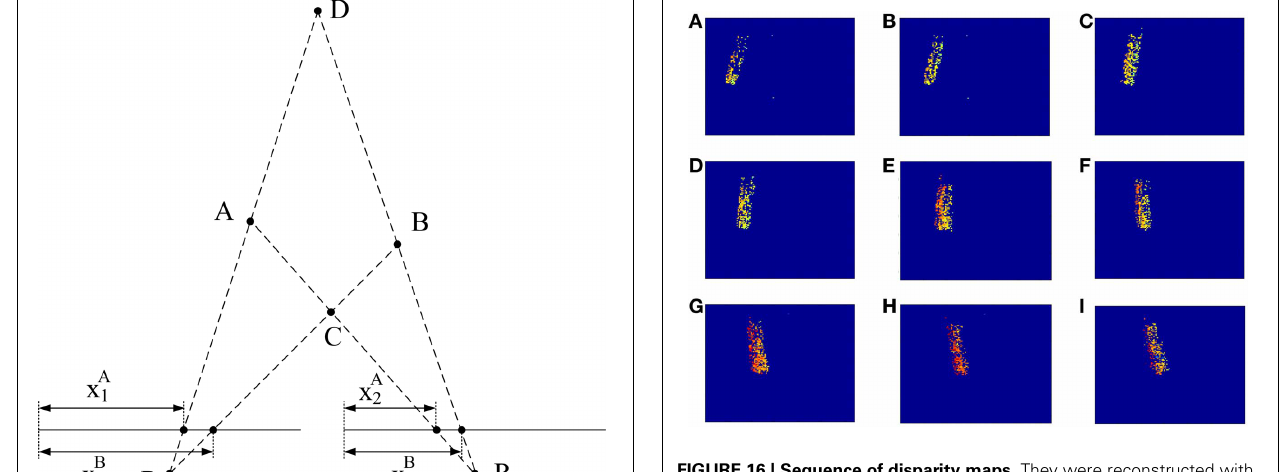
FIGURE 16 | Sequence of disparity maps. They were reconstructed with T frame = 50 ms and they correspond to the movement of the swinging pen (from A – I ). The disparity scale goes from dark blue to red to encode events from far to near.